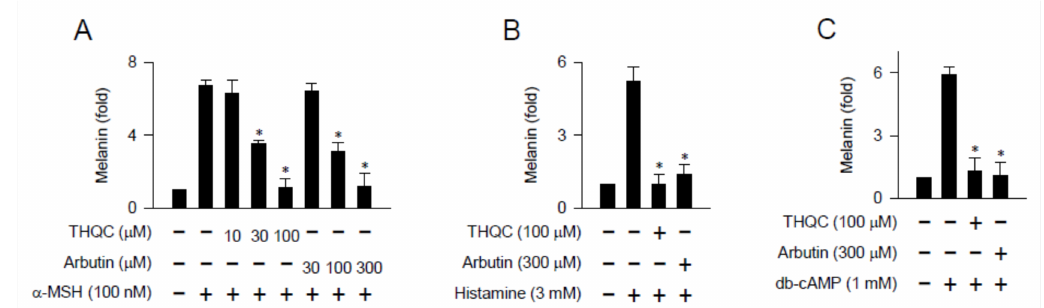
Figure 2. E ff ect of THQC on melanin production in B16-F0 culture. B16-F0 cells were stimulated with α -melanocyte-stimulating hormone ( α -MSH) ( A ), histamine ( B ), or dibutyryl (db)-cAMP ( C ) for 72 h in the presence of THQC. Melanin pigment was quantified by measuring absorbance value at 405 nm and is represented as relative fold. * p < 0.05 vs. α -MSH, histamine, or db-cAMP